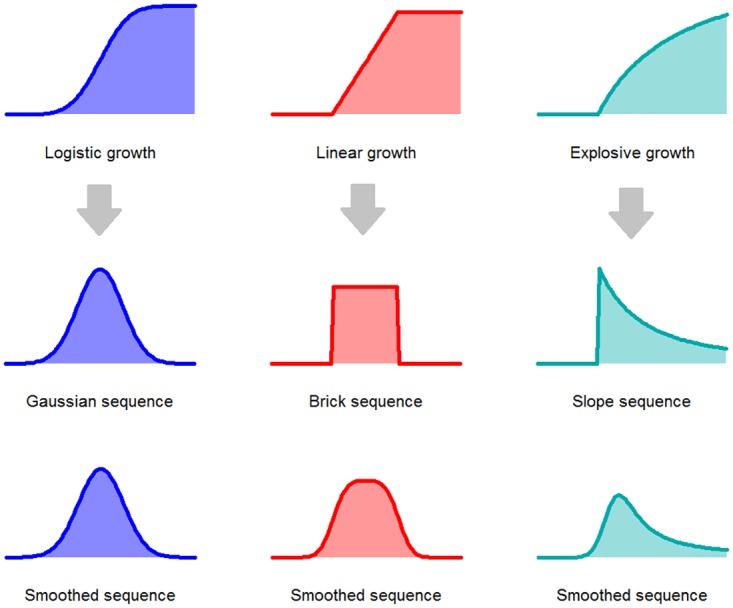
Basic components.The function used as components, smoothed functions and the type of growth represented by these components.